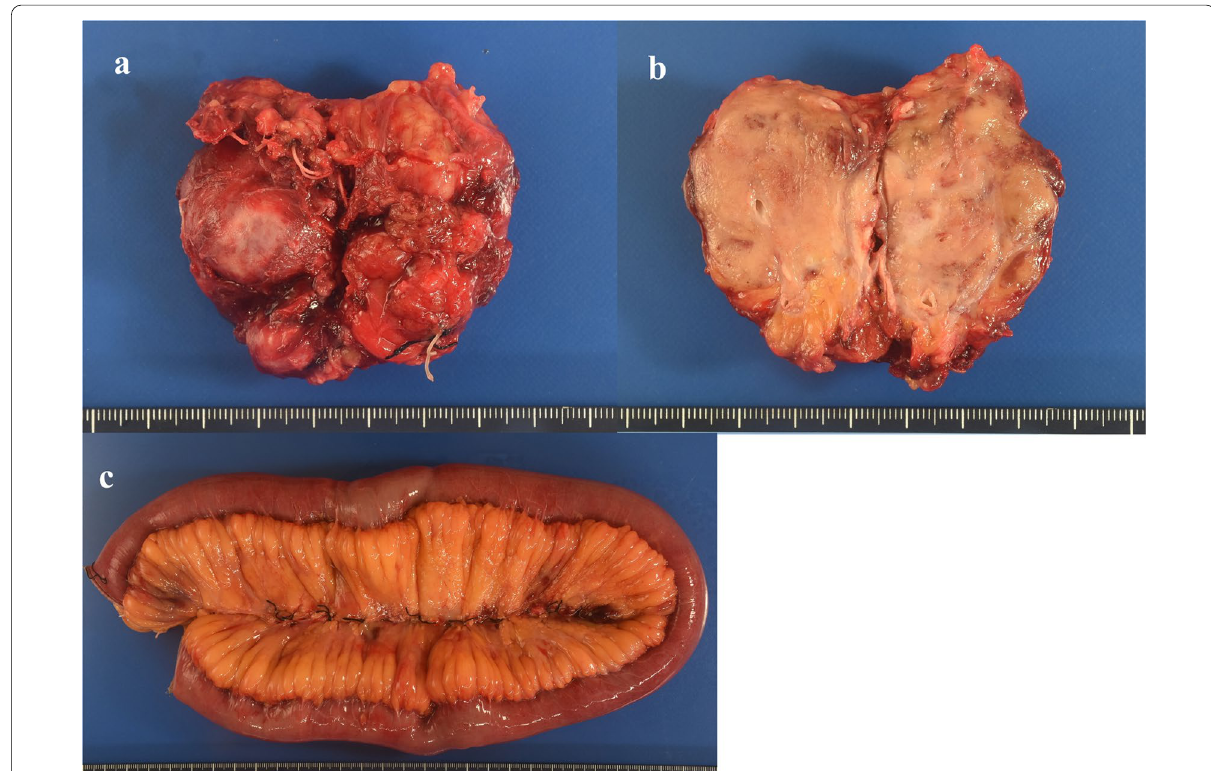
Fig. 4 Resected specimens. a Tumor resected together with the surrounding mesentery. The tumor size is 55 pale yellowish-white. c Additional resected ileum (90 cm). It is congested, but no tumor is found